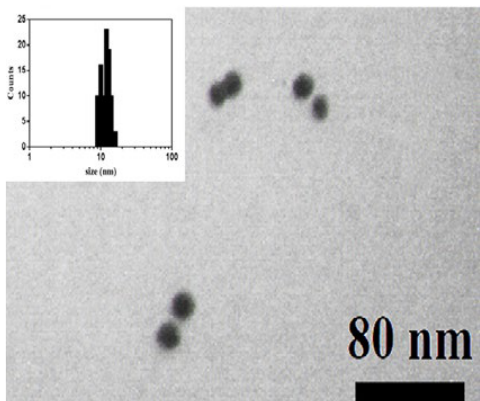
Fig. 3. TEM image of gold nanoparticles which synthesized by ‘inversed Turkevich’ method at 95 °C and 15.0 Sodium citrate to Fig.2. TEM image of gold nanoparticles which synthesized by ‘reversed Turkevich’ molar ratio. HAuCl 4 method at 95 °C and 15.0 Sodium citrate to HAuCl 4 molar ratio.